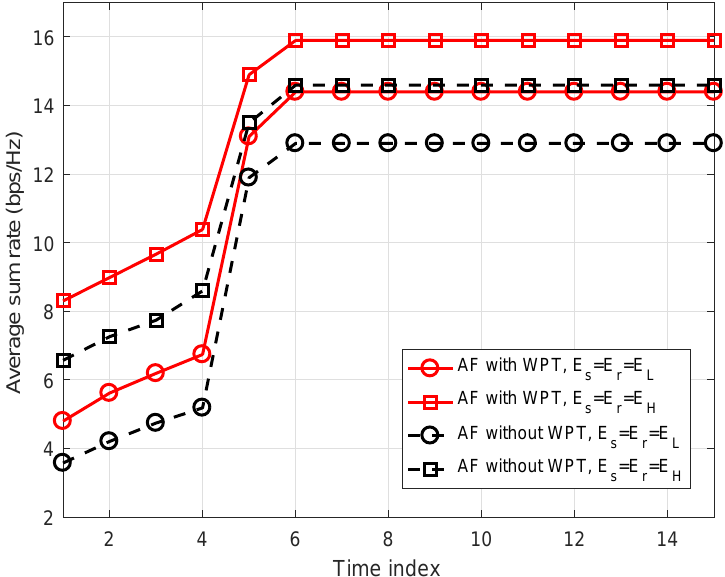
Figure 3. Scenario 1 ( E s = E r ): Average sum rate performance vs. time index ( N = 4, d sr = 1 m and d rd = 50 m).